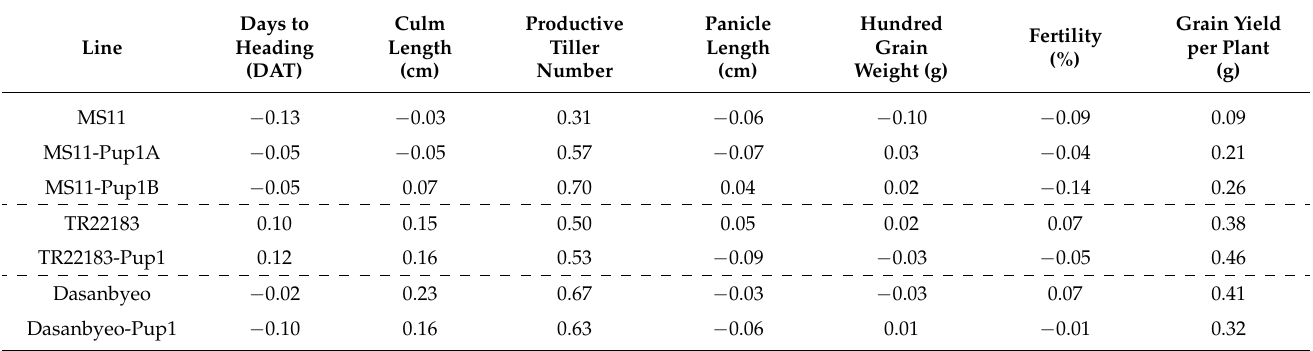
Table 6. Relative response of the temperate-Pup1 breeding lines to P fertilizer application under rainfed conditions. Values were obtained using the formula (Response to P-supplied condition– response to P-non-supplied condition)/(Response to P-non-supplied